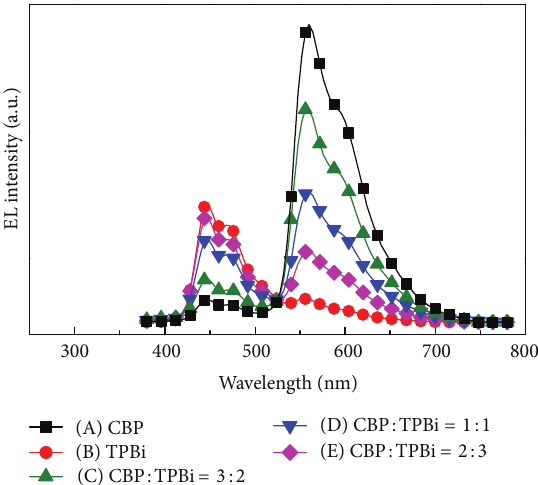
Figure 3: The relationship of EL intensity versus wavelength of HWOLEDs (Devices A, B, C, D, and E) at 5 mA/cm 2 .